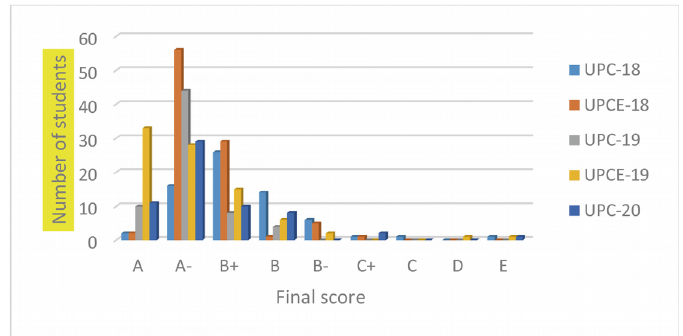
Figure 1. The Recapitulation of final score on chemical thermodynamics course Figure 1 described students’ final score on chemical thermodynamics after programed in different semesters. The final score is obtained from score conversion at 0-100 scale becomes 0-4 scale and alphabet A-E based on academic guideline of Universitas Negeri Surabaya, with details of A (scale value 4 for interval score 85 ≤ x < 100), A- (scale value 3,75 for interval score 80 ≤ x < 85), B+ (scale value 3,5 for interval score 75 ≤ x < 80), B (scale value 3 for interval score 70 ≤ x < 75), B- (scale value 2,75 for interval score 65 ≤ x < 70), C+ (scale value 2,5 for interval score 60 ≤ x < 65), C (scale value 2 for interval score 55 ≤ x < 60), D (scale value 1 for interval score 40 ≤ x < 55), and E (scale value 0